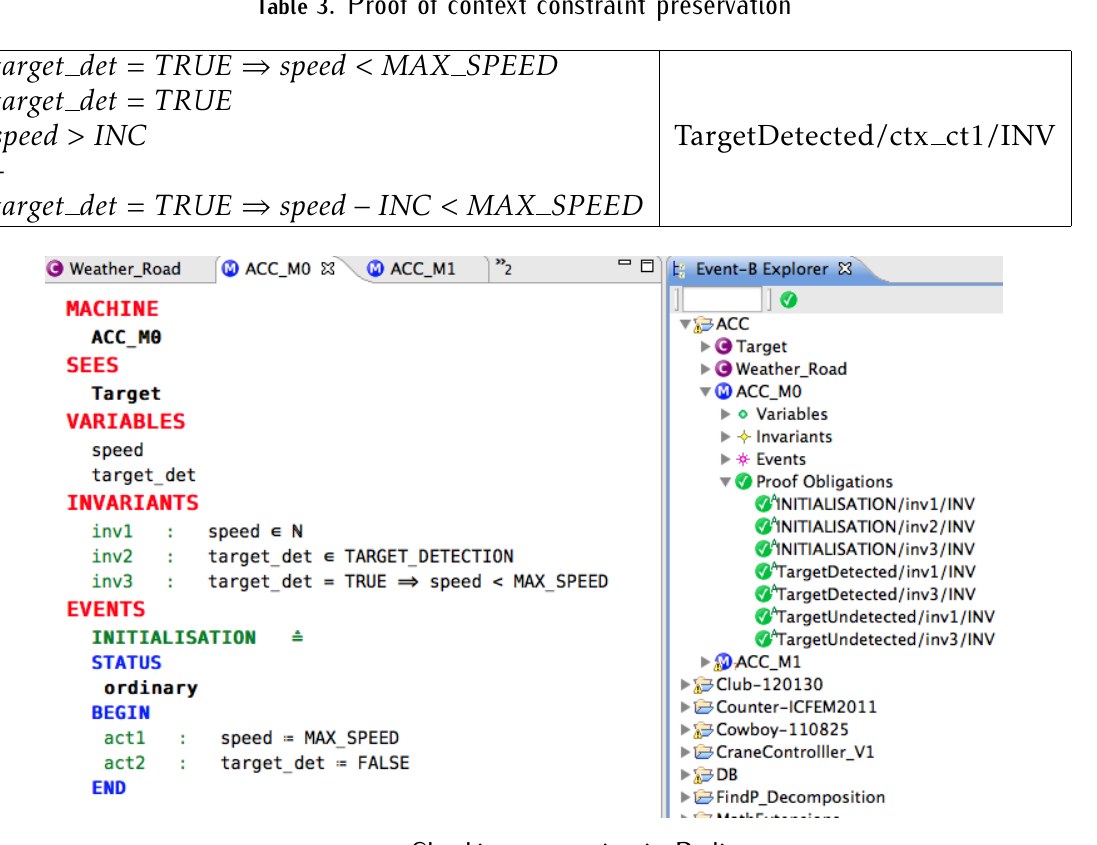
Figure 9. Checking properties in